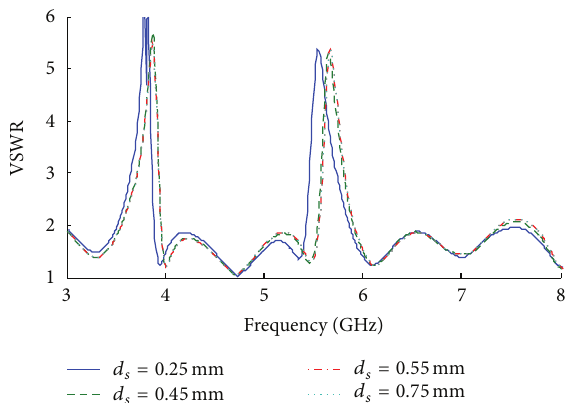
Figure5:AVAVSWRsimulationresultsforfourdifferentscenarios.